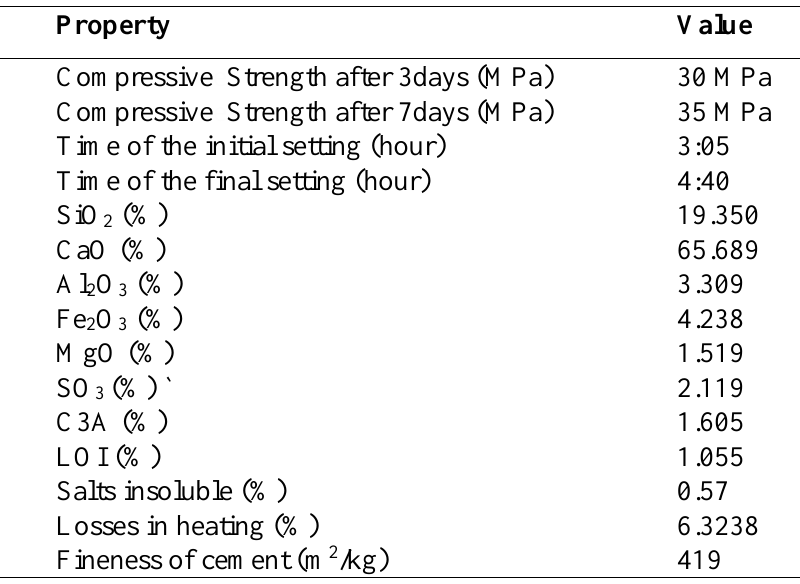
Table 3. Cement used in percent